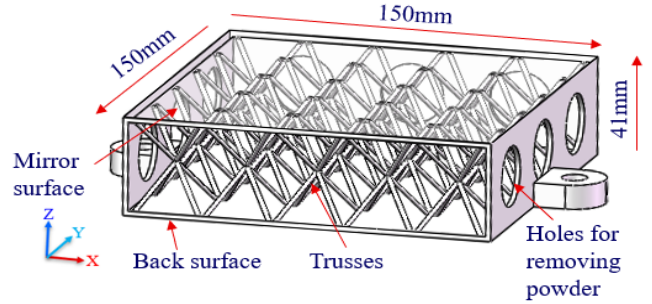
Figure 2. Cut view of the mirror model with single-layer truss structure.